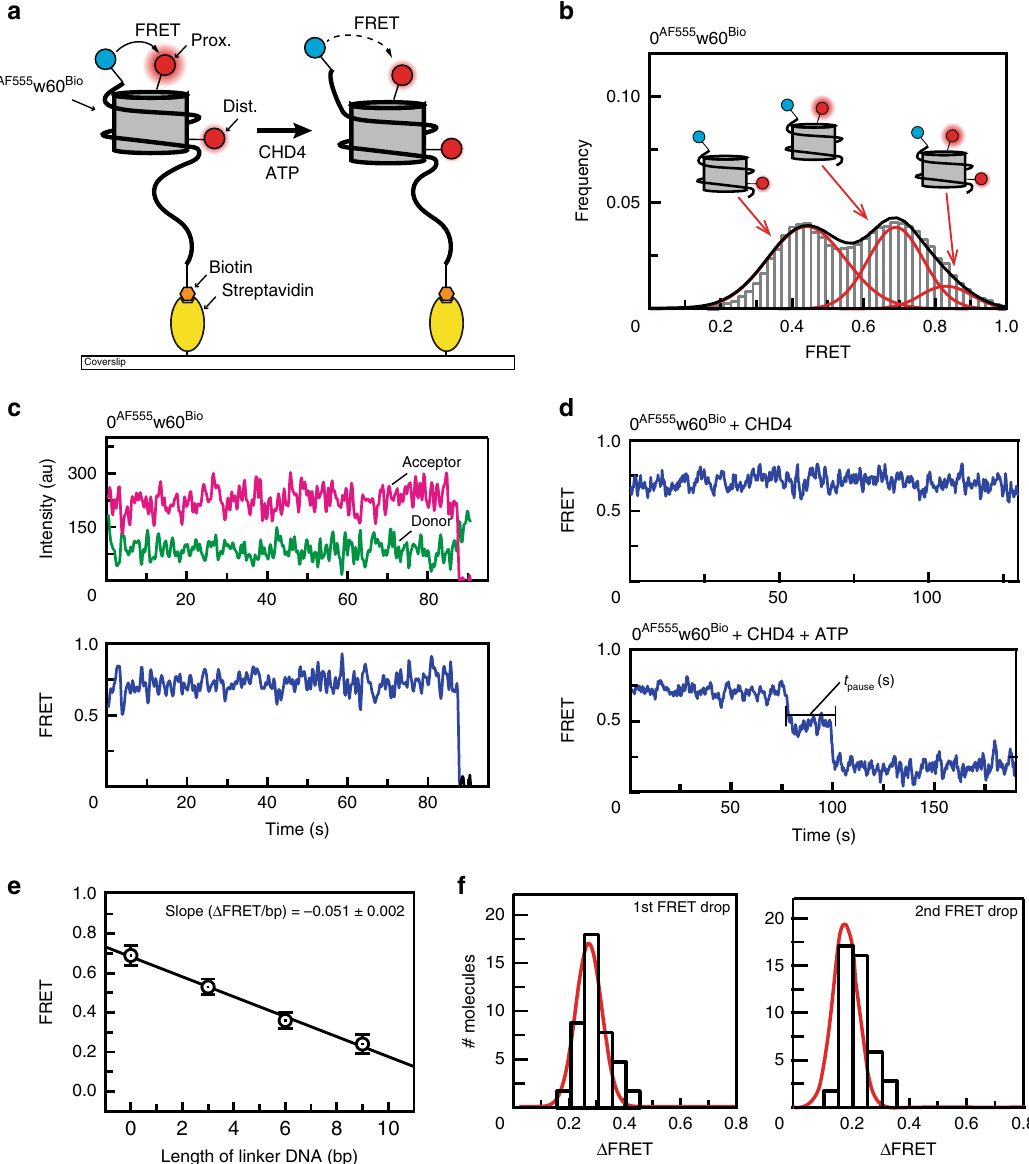
Fig. 3 A single-molecule FRET (smFRET) assay for nucleosome sliding shows that CHD4 drives multi-base-pair movements of nucleosomal DNA at the exit side. a Diagram depicting the setup for the smFRET assay and nucleosome substrate before and after remodelling by CHD4. A 0 AF555 w60 Bio nucleosome containing either proximal or distal or both AF647-labelled H2A is assembled onto a PEGylated coverslip via biotin at the longer end of the fl anking DNA (AF555 and AF647 are represented by blue and red circles, respectively). FRET is then monitored as a function of time under different conditions. b Pre-reaction distribution of nucleosomal FRET states for 0 AF555 w60 Bio nucleosomes. Low, mid- and high-FRET states correspond to particles containing H2A in the distal, proximal or both positions (relative to the DNA-bound AF555), respectively. c FRET vs time trace of 0 AF555 w60 Bio nucleosome bearing a proximal H2A label. Donor AF555 fl uorescence (green), acceptor AF647 fl uorescence (magenta) and FRET (blue) are shown. d FRET vs time traces of 0 AF555 w60 Bio nucleosome bearing a proximal H2A label in the presence of 2 nM CHD4 (top) or both 2 nM CHD4 and 1 mM ATP (bottom). Two clear drops in FRET are observed in the latter. We de fi ne the pause time t pause as the duration between two FRET changes. e Calibration of FRET values for n AF555 w60 Bio nucleosomes. The FRET of proximally labelled particles was measured as a function of the number of base pairs ( n ) added to linker DNA at the exit site and mid-FRET peak values for each construct were obtained by fi tting to a Gaussian distribution. Plotting the change in mid-FRET value as a function of n yielded a slope of – 0.051 ± 0.002. Error bars represent standard deviation of the fi t from at least two independent measurements. f Distribution of the 1st and 2nd step sizes for 40 molecules undergoing remodelling in presence of 2 nM CHD4 and 1 mM ATP. The histograms are fi tted to a Gaussian both proximal and distal labels undergo two steps of photo- Next, we treated 0 AF555 w60 Bio nucleosomes with both CHD4 bleaching (Supplementary Fig. 1c). Similarly, introducing CHD4 and ATP in a continuous fl ow manner and monitored FRET as a alone has no effect (Fig. 3d), indicating CHD4 binding does not function of time. A stepwise reduction in FRET was seen, induce any signi fi cant conformational changes in the nucleo- indicating that the two fl uorophores had moved further apart some that alter the distance between the two fl uorophores. (Fig. 3d and Supplementary Fig. 1d). The traces consistently